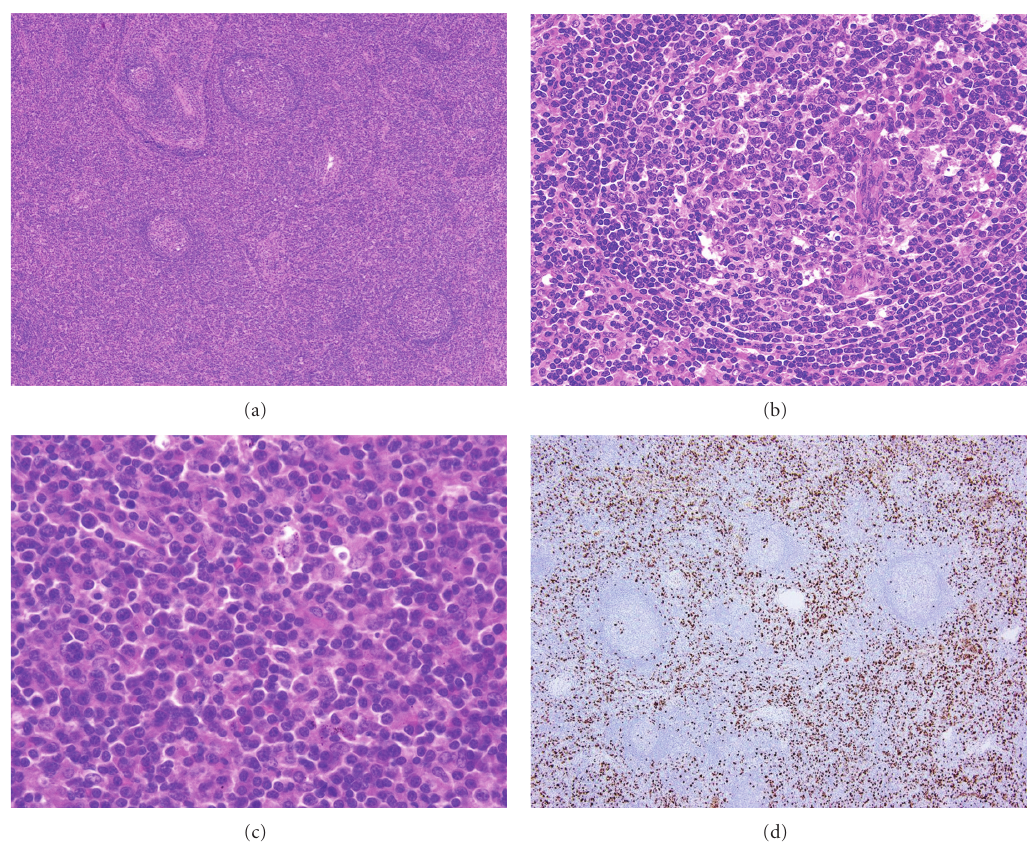
Figure 1: IgG4-related lymphadenopathy (type I). (a) The lymph node shows interfollicular expansion with normal to hyperplastic germinal centers. (b) The germinal centers are penetrated by blood vessels. (c) A large number of mature plasma cells with small lymphocytes are seen. (d) Immunostaining shows numerous IgG4 + cells in the interfollicular zone.